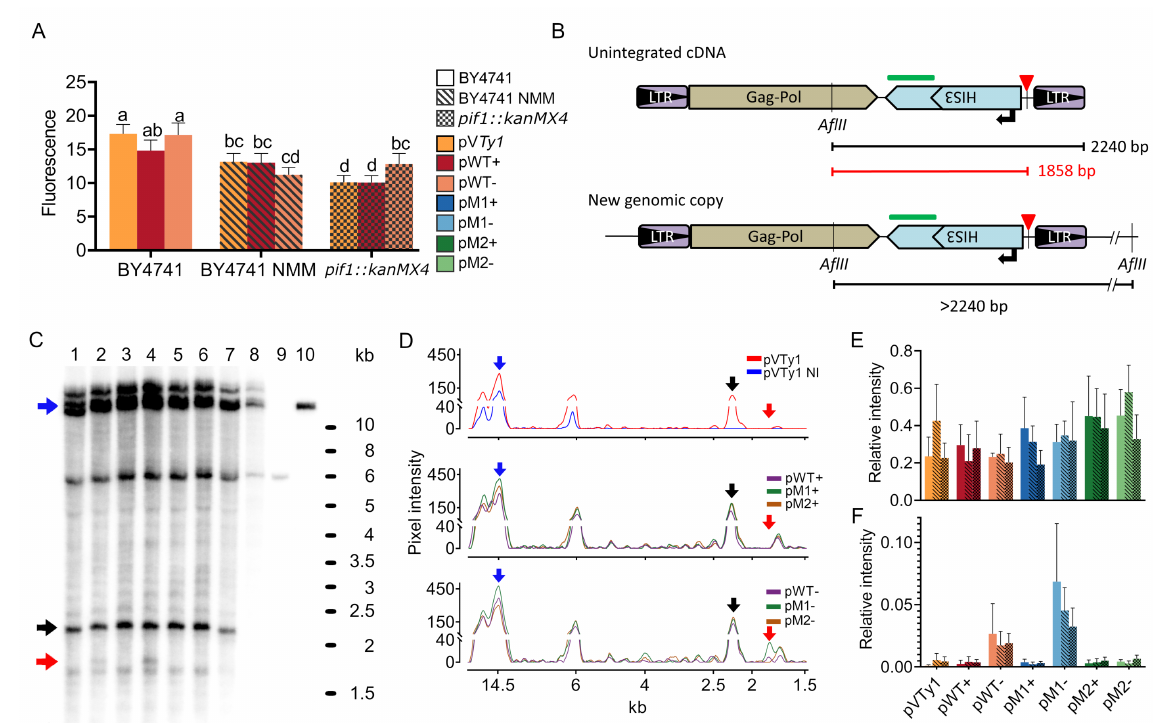
Figure 5. Measurement of Ty1his3-AI mRNA levels by real-time PCR and analysis of reverse transcription products by Southern blot. ( A ) mRNA relative quantities of plasmid borne Ty1his3-AI measured by real-time PCR showing only a slight inhibitory effect of G4 but also overall reduction of mRNA by both NMM treatment and pif1::kanMX4 . The mRNA levels were normalized to the plasmid-borne URA3 mRNA. Significantly different expression levels are indicated by different letters (One way ANOVA, Tukey’s HSD test; p ≤ 0.05). ( B ) Schematic of Southern blot design of unintegrated cDNA and genomic copy indicating hybridization probe position (green rectangle) and relevant AflII sites. The probe detected a 2240 bp AflII fragment corresponding to unintegrated Ty1his3-AI cDNA and various longer fragments originating from the junction of Ty1his3-AI and chromosomal DNA. ( C ) Southern blot analysis of AflII -digested total cellular DNA of cultures induced for Ty1his3-AI retrotransposition by cultivation at 22 ◦ C in galactose containing media (except for line 8, glucose). Plasmid, cDNA and interrupted products of reverse transcription are indicated by blue, black and red arrows, respectively. Band around 6 kb originates from a gDNA fragment containing his3 ∆ 1 . Lines: (1) pWT+; (2) pWT − ; (3) pM1+; (4) pM1 − ; (5) pM2+; (6) pM2 − ; (7) pV Ty1 ; (8) pV Ty1 non-induced (NI); (9) BY4741 without plasmid; (10) pV Ty1 isolated plasmid. ( D ) Signal intensity of selected lines. For better visualization, the curves were aligned so that corresponding peaks match. ( E ) Quantification of unintegrated cDNAs normalized to plasmid intensity. ( F ) Quantification of interrupted products of reverse transcription normalized to plasmid intensity. Plotted values are means and standard deviations of three biological replicates (independent cultures), except for NMM representing only two